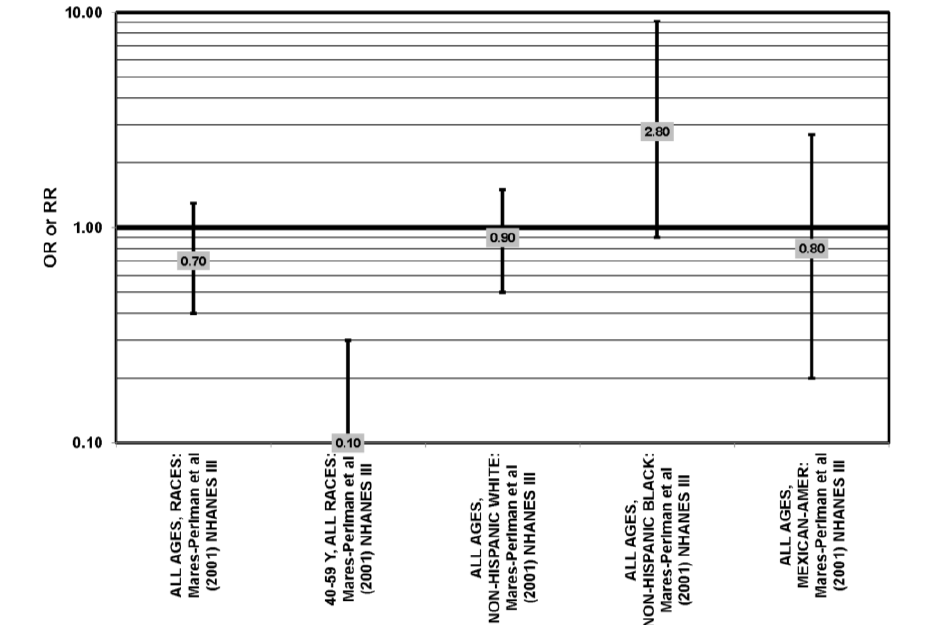
Figure 25. Odds or risk ratio for pigmentary abnormalities; high vs. low intake of lutein and zeaxanthin: retrospective and cross-sectional